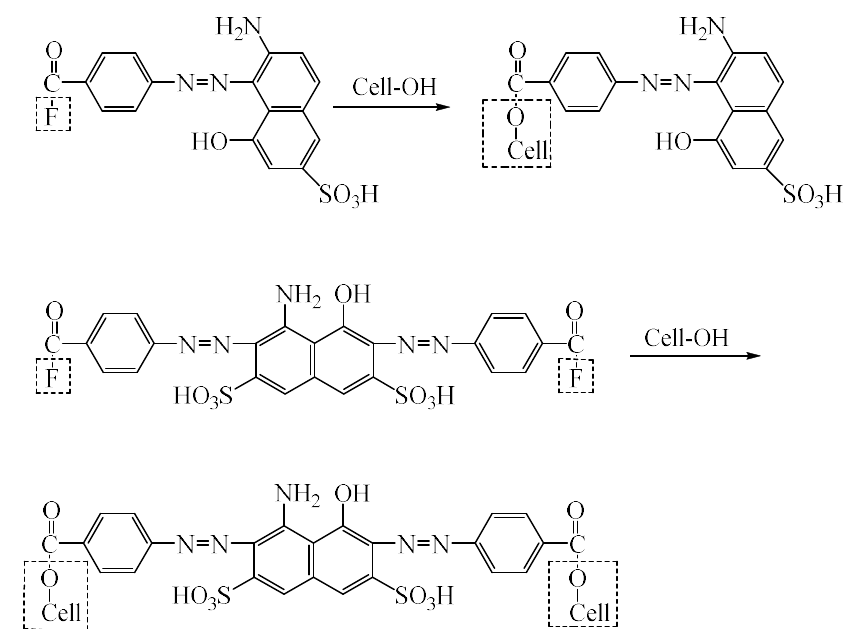
6 of 12 Figure 3. ( a ) Fixation and exhaustion of dyes with added sodium sulfate. ( b ) Fixation and exhaustion of dyes without adding sodium sulfate. 2.4. Dyeing Properties of the Synthesized Dyes It is common knowledge that the exhaustion and fixation rate are significant charac-